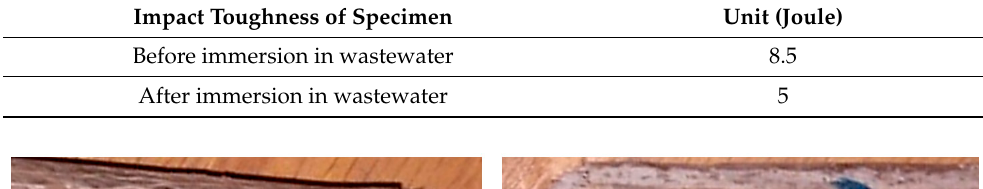
Table 3. Impact energy of Charpy test.